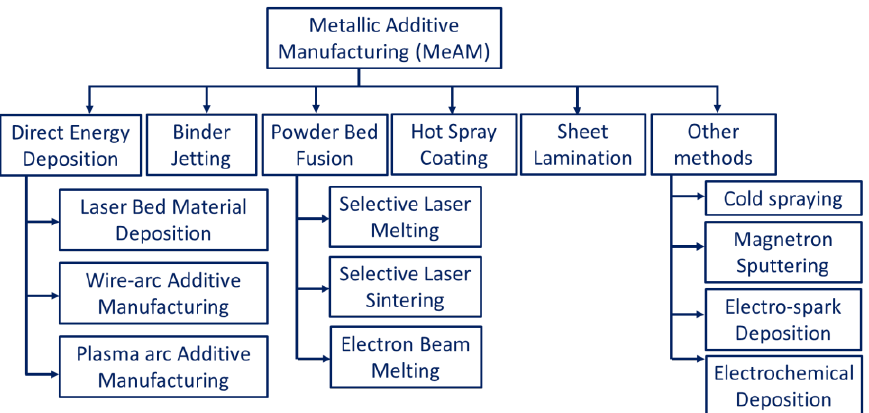
Figure 2. Broad classification of metallic additive manufacturing processes.